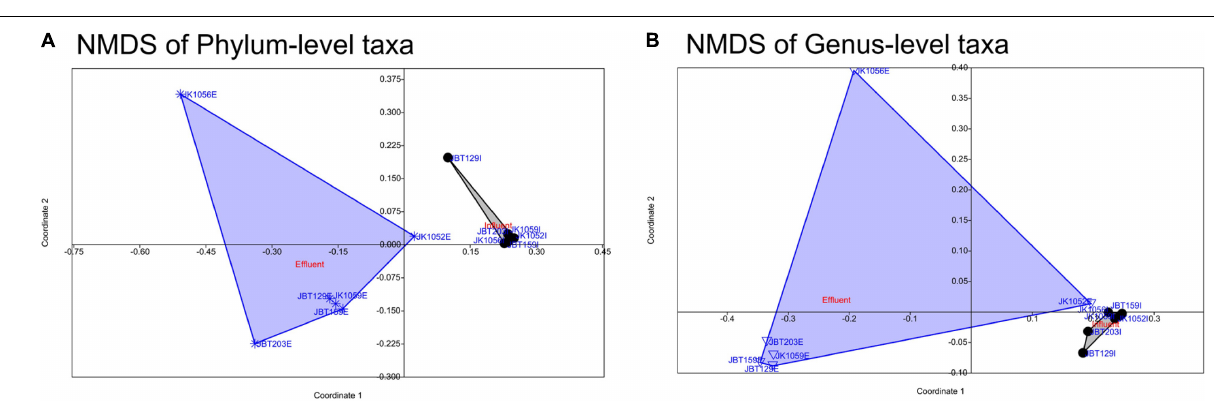
FIGURE 6 | Non-multidimensional scaling of (A) phylum-level (ANOSIM statistical test of the Bray–Curtis similarity index, p -value = 0.0015) and (B) genus-level (ANOSIM statistical test with the Bray–Curtis similarity index, p -value = 0.007) microbial taxa